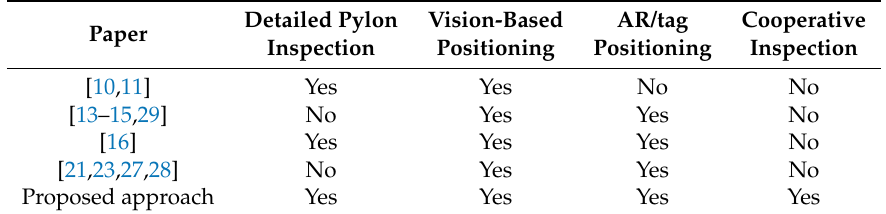
Table 1. Related